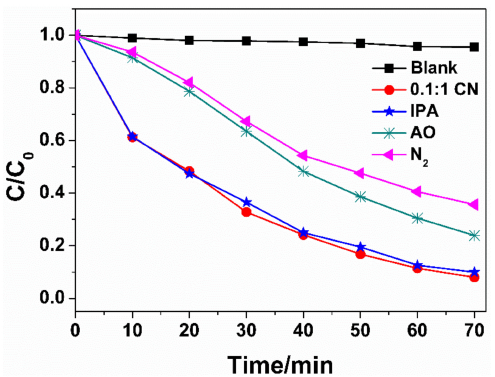
Figure 8. Effect of several scavengers on the photocatalytic activity of 0.1:1 CN sample.